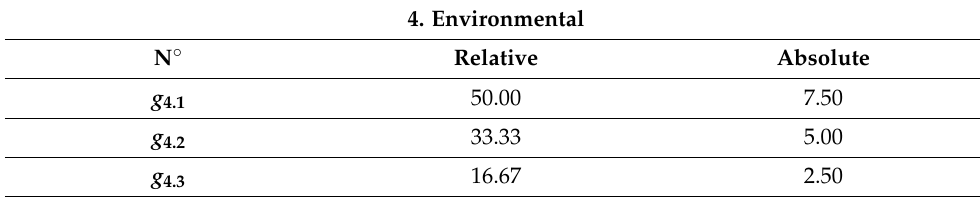
Table 9. Weighting of the environmental criteria.